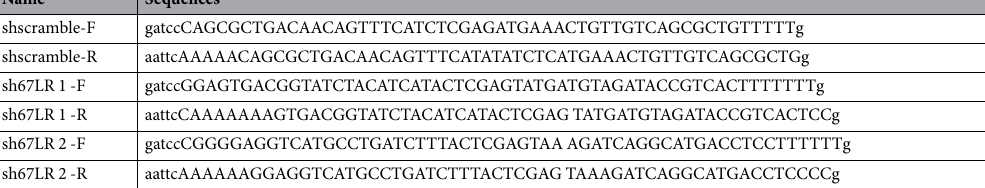
Table 1. The 67LR shRNA knockdown